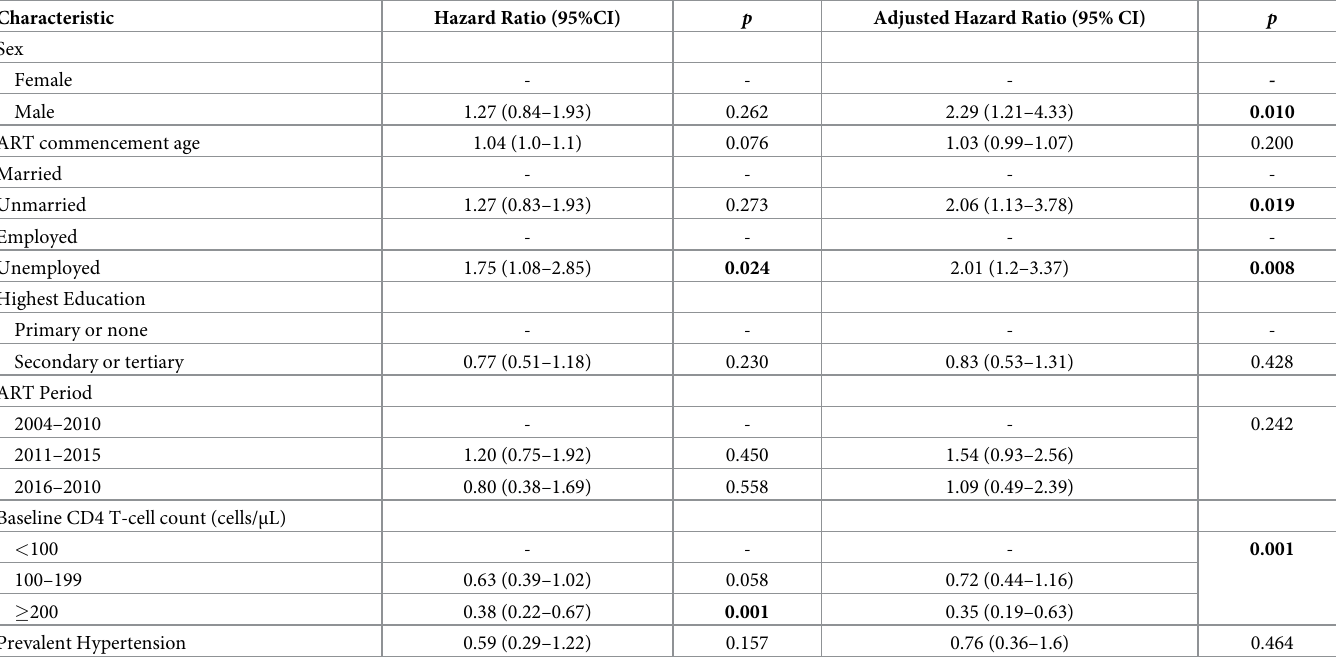
Baseline WHO clinical stage was omitted from multivariable analysis due to collinearity with baseline CD4 T-cell